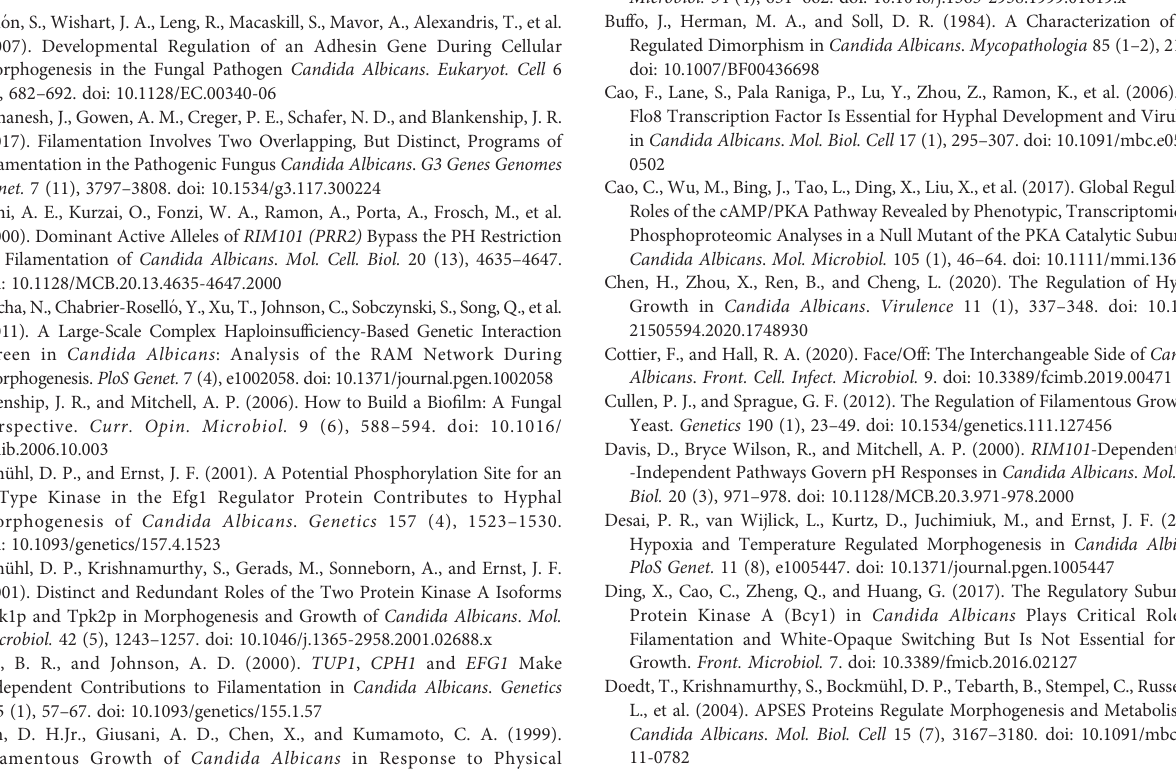
Supplementary Table 1 | Efg1 targets with two fold change upon deletion of EFG1. (A) Bio fi lm- Changes in RNA expression between the efg1 D / D deletion mutant and wild type under bio fi lm formation conditions (Spider medium at 37°C in 6-well polystyrene plates) determined by RNA sequencing. Efg1 binding sites